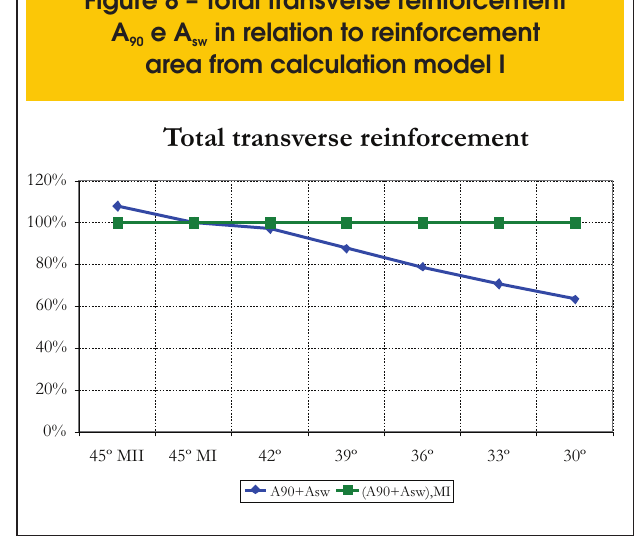
Figure � � �otal transverse reinforcement A e A in relation to reinforcement 90 sw area from calculation model